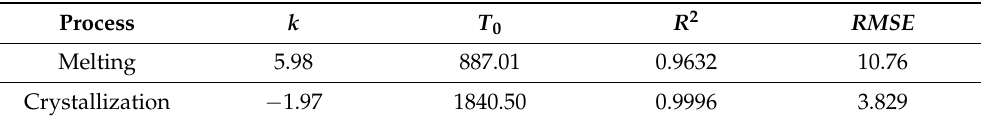
Table 6. Relationships between temperature and